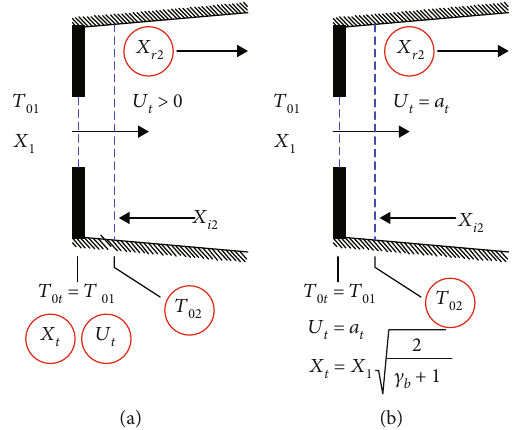
Figure 8: Boundary constraints and unknown parameters for (a) subsonic and (b) choked in fl ow (unknowns are